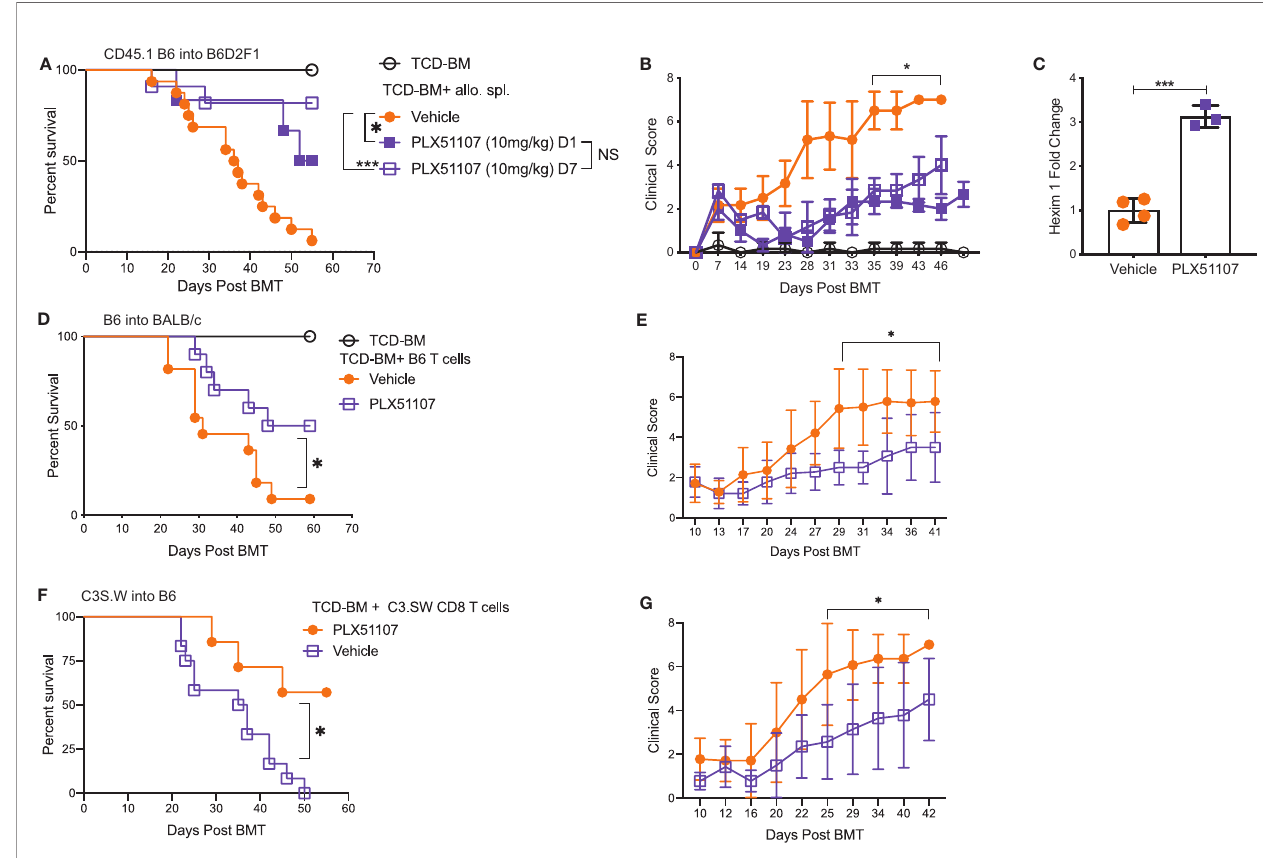
FIGURE 1 | BET inhibitor PLX51107 signi fi cantly improves survival in mouse model of aGVHD. (A) Lethally irradiated F1 recipients received T cell depleted bone marrow cells (TCD-BM) along with CD45.1 B6 splenocytes transferred intravenously. Recipient mice were treated with vehicle (n=16) or PLX51107 (10mg/kg) by oral gavage three times weekly starting either at day day +1 (n=6) or day +7 (n=11) post-transplant. Survival curve. Log-rank test was used to compare survival. (B) Clinical scores. (C) Mice were bled after one week of dosing, six hours after last dose. Hexim1 expression in PBMCS by quantitative real-time PCR. (D) Lethally irradiated BALB/c recipients received TCD-BM along with T cells from B6 donors. Recipients were treated three times weekly by oral gavage with PLX51107 (n=10) or vehicle (n=11). Survival curve. (E) Clinical scores. (F) Lethally irradiated B6 recipients received TCD-BM plus CD8 T cells from C3.SW donor mice. Recipients were treated with PLX51107 (n=7) or vehicle (n=12) by oral gavage three times weekly beginning day +7 post-transplant. Survival curve. (G) Clinical scores. All murine transplant experiments were performed independently 2-3 times with n=3-8 mice per cohort in each experiment, data pooled from independent transplant experiments. *p < 0.05, ***p <